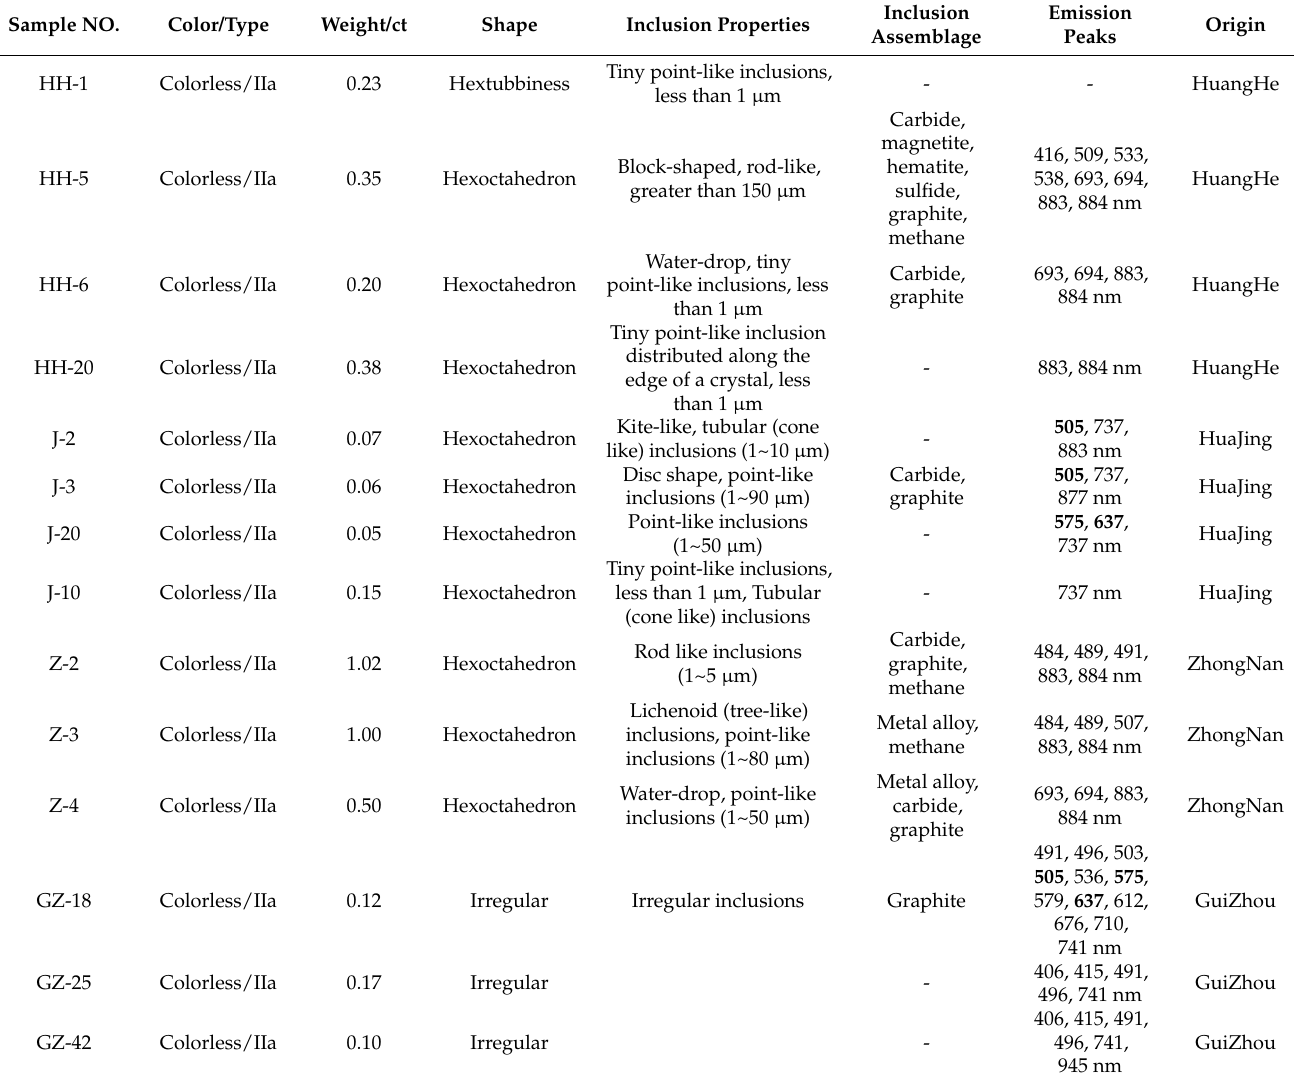
Table 1. Characteristic of Chinese HPHT synthetic diamonds in recent